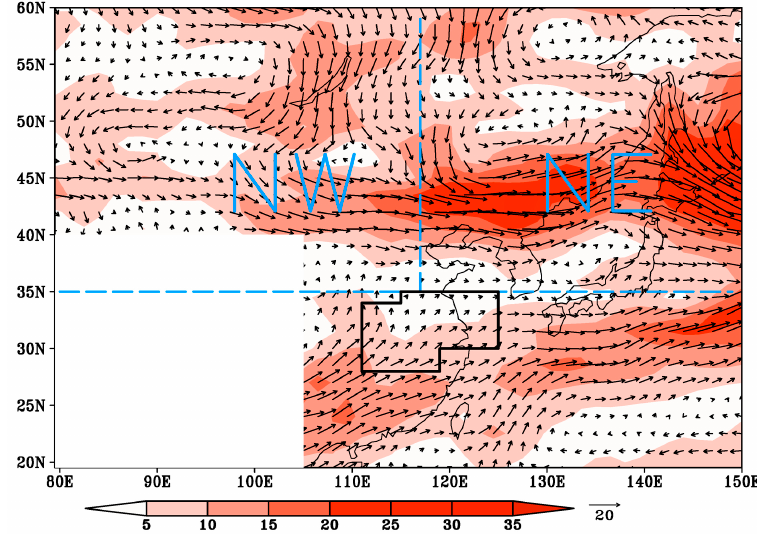
Figure 2. The climatology of the wind field at 700 hPa (vector), with the shaded areas representing their wind speed (m · s − 1 ). The black box denotes the Changjiang River–Huaihe River Valley (CHV). The northwest (NW) and northeast (NE) of China are divided into two blue dashed rectangles.